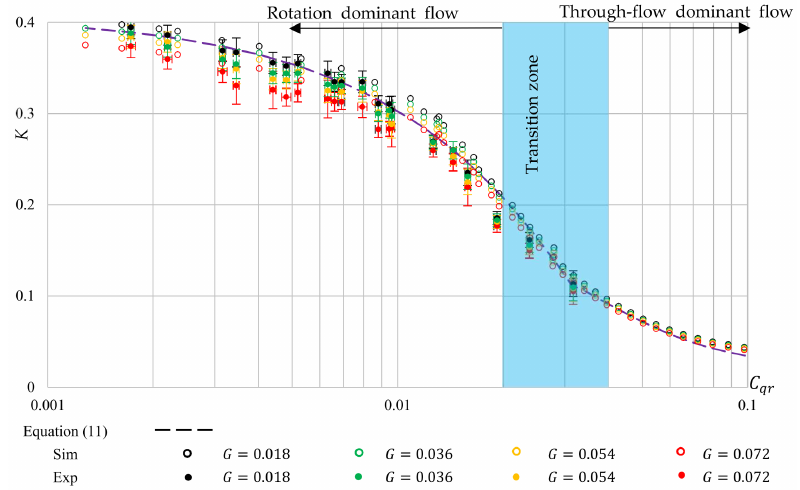
Figure 9. K ( C qr ) curve ignoring the impact of G . C qr : local flow rate coefficient; G : non-dimensional axial gap; K : core swirl ratio.